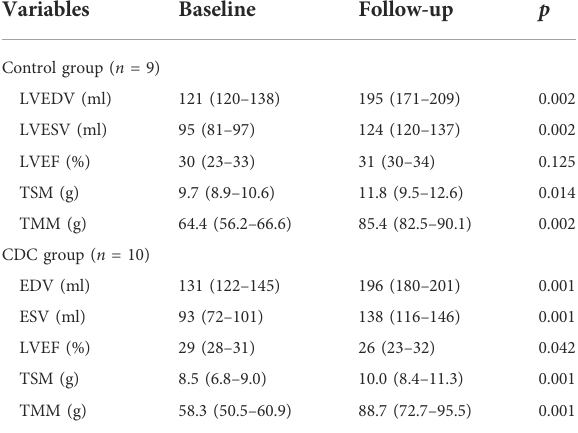
TABLE 2 Evolution of left ventricular function, leftventricular volume, scar mass, and healthy myocardial mass as evaluated with CMR. Shown are the median values of the variables and the p -value of the contrast of hypotheses (Wilcoxon test). LVEDV = end-diastolic left ventricular volume. LVESV = end-systolic left ventricular volume. LVEF: left ventricular ejection fraction. TMM: total myocardial mass. TSM: total scar